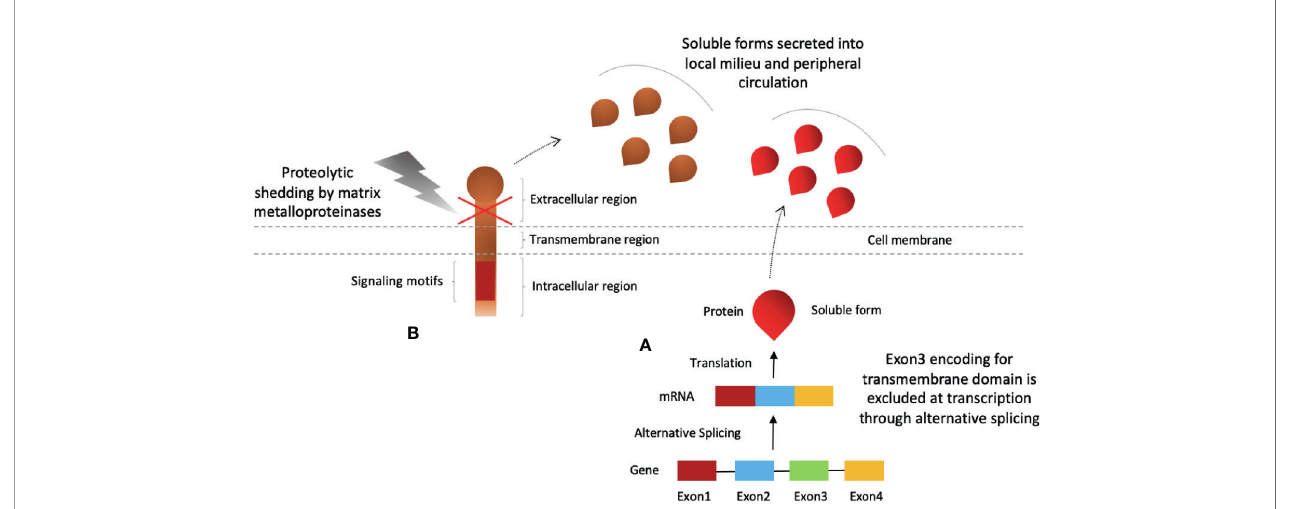
FIGURE 2 | Production of soluble forms of CD28-B7 family coinhibitory immune checkpoint molecules. Soluble checkpoint proteins are produced by two mechanisms; (A) alternative splicing, and (B) proteolytic shedding of extracellular